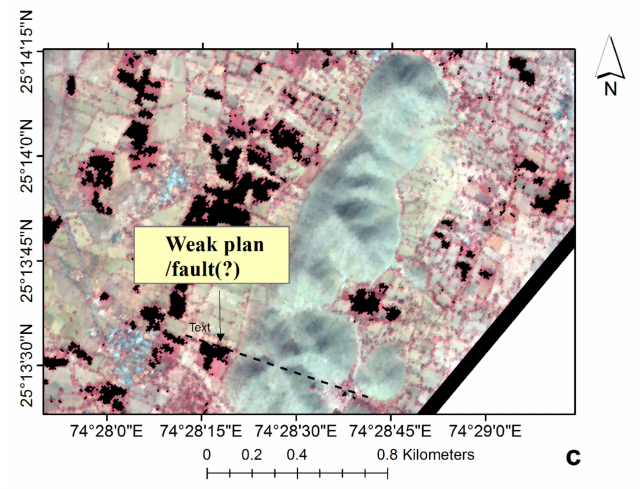
Figure 8. ( a ) FCC image of calcite, sericite, and Gossan relative band depth (RBD) to delineate the presence of pegmatite and silica rich, sericitized zones associated with BMQ in GurlaMomi area. ( b ) Surface exposures of Banded Magnetite Quartzite (BMQ)-rich zones identified in thresholded fit image (derived as the ratio of scale and RMS error image of MRSFF method). ( c ) FCC image composite of AVIRIS-NG bands of the same area are also shown to show. In this image, Red = 950 nm, Green = 650 nm, and Blue = 560 nm.